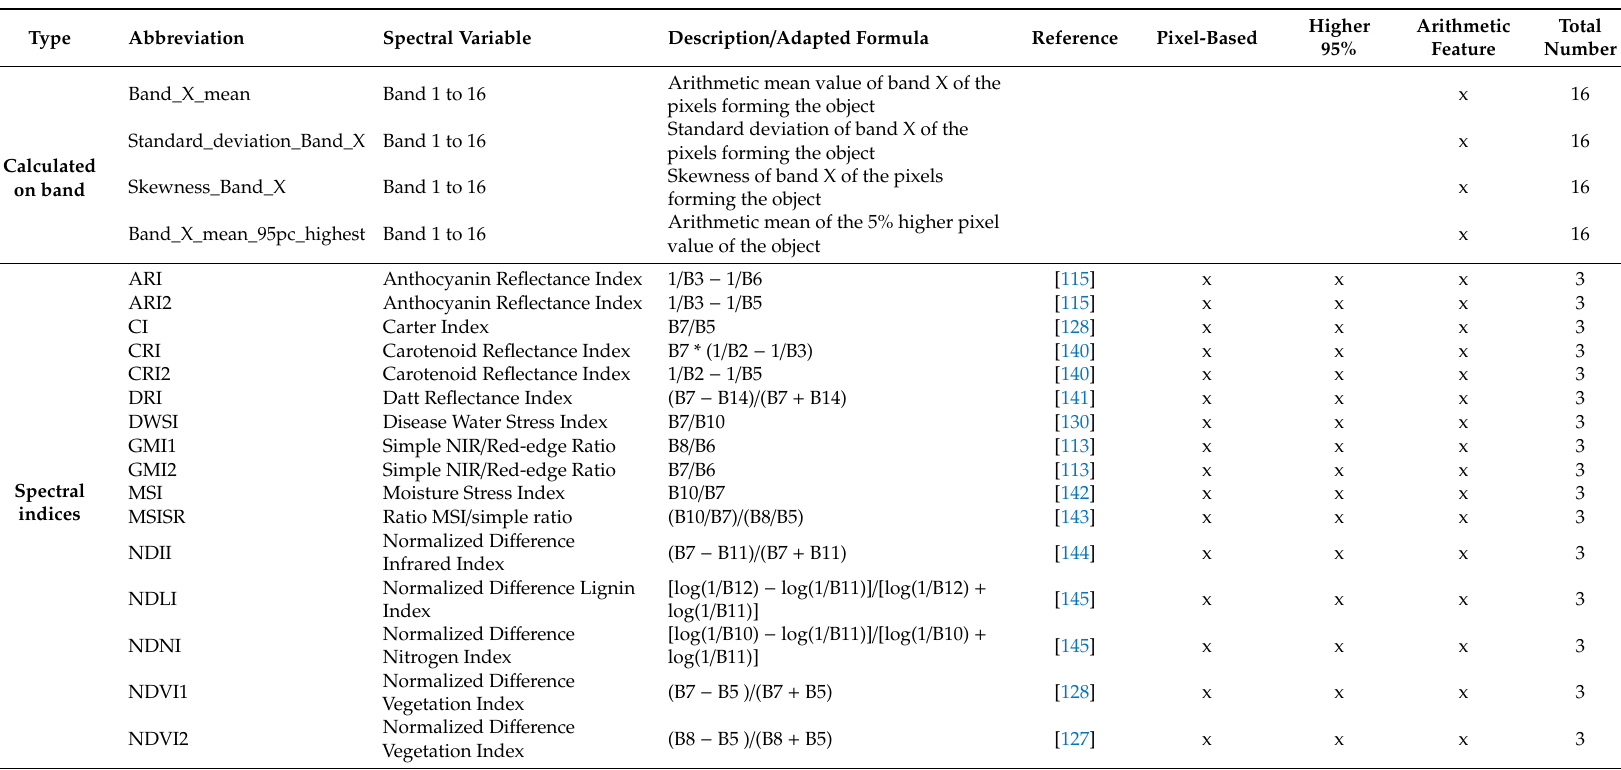
Table A1. Variables’ details. For pixel-based spectral indices, the abbreviation is “variable_mean_pixel”, for spectral indices calculated with 95th percentile highest pixels, the abbreviation is “variable_mean_95pc_higher”, for arithmetic feature calculated for spectral indices, the abbreviation is “variable_mean”. Band numbers are described in Table